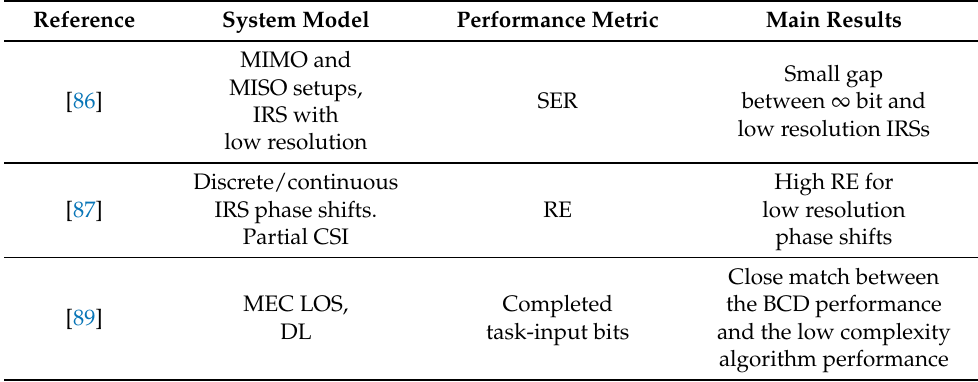
Table 6. Multiuser MIMO